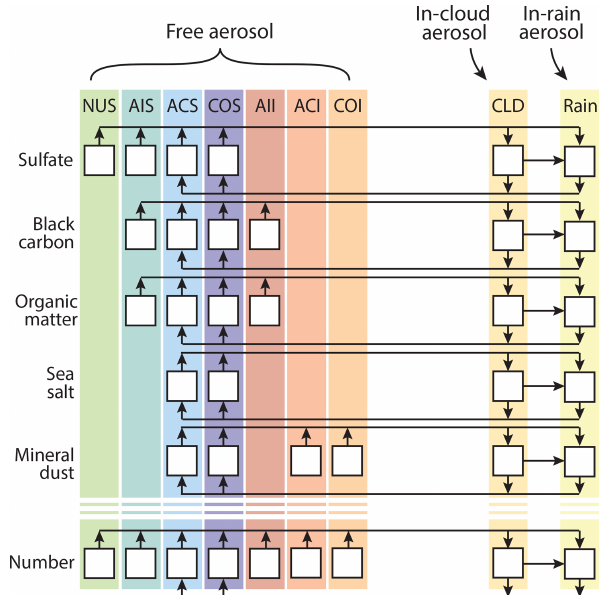
Figure 1. Overview of the aerosol framework, where the free aerosol section is the original M7 representation of the aerosol pop- ulation. The extension of this framework in the current work is rep- resented by the prognostic variables for in-cloud and in-rain aerosol mass. Cloud and rain particle number coincide with the correspond- ing parameters in the SB bulk microphysics scheme. Arrows repre- sent possible pathways for the aerosols to transfer between